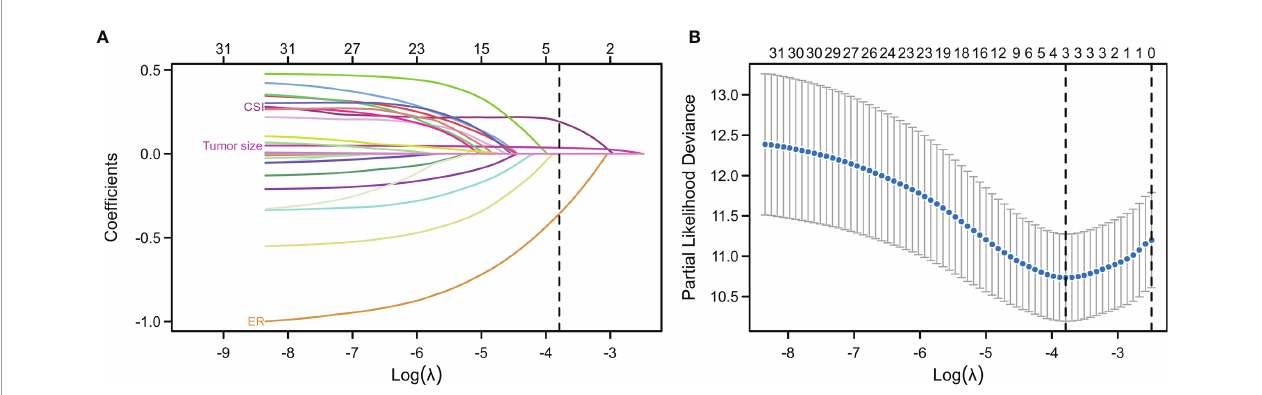
FIGURE 2 | Least absolute shrinkage and selection operator (LASSO) regression analysis for the selection of characteristic parameters. (A) Penalty diagram for coef fi cients of thirty-one characteristic variables. As the penalty coef fi cient lambda changes, the number of compression variable coef fi cients increases continuously. Finally, most of the variable coef fi cients are compressed to zero. (B) In the LASSO Logistic regression model, the optimal penalty coef fi cient lambda was selected by using 10-fold cross-validation and minimization criteria. The optimal lambda (lambda = 3) was selected at the lowest point of the curve, and three variables with non-